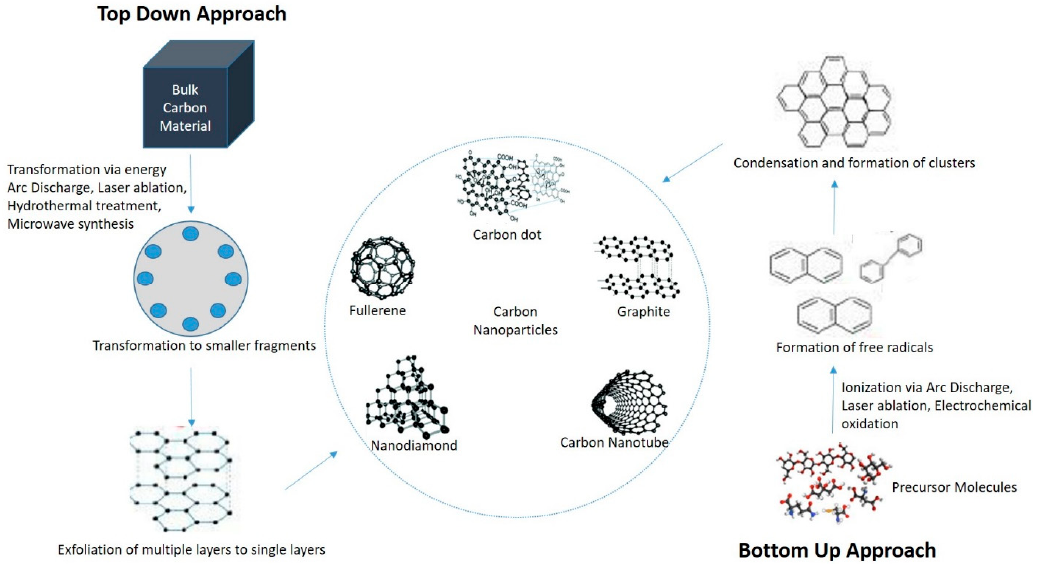
Figure 1. Various approaches and methods used to form carbon-based nanoparticles. Table 1. Advantages and disadvantages of different methods of C-dots synthesis.